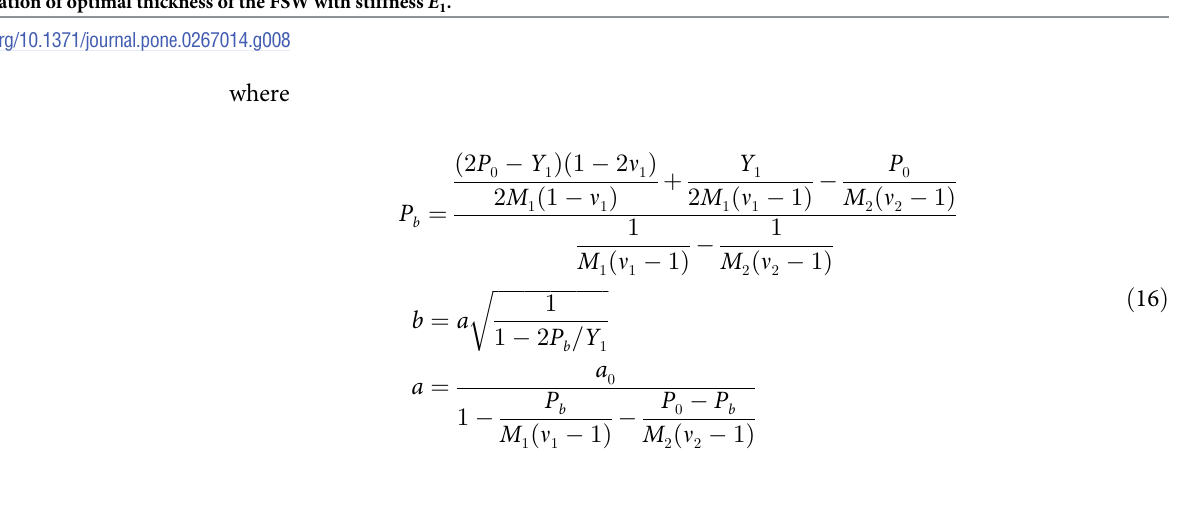
Fig 8. Variation of optimal thickness of the FSW with stiffness E 1